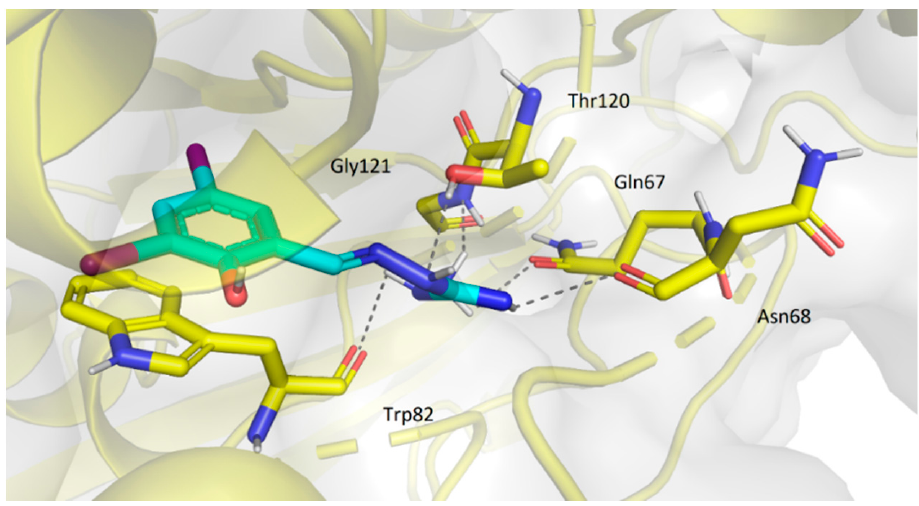
Figure 17. The binding mode of 2e (cyan) in BuChE. Compound 3b differs significantly from the other ligands in its position in the enzyme (Figure 18), which corresponds with poor in vitro results. This ligand was located deep within the gorge near the active site Ser198. Few possible hydrogen bonds stabilized the ligand in its pose (Gly115, Gly116, Tyr128,